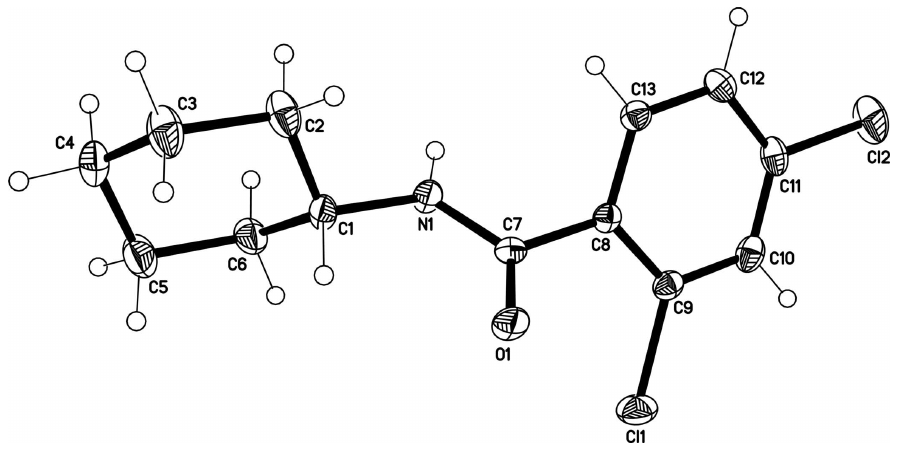
Figure 1 The molecular structure of the title molecule, with the atom-numbering scheme. Displacement ellipsoids are drawn at the 50% probability